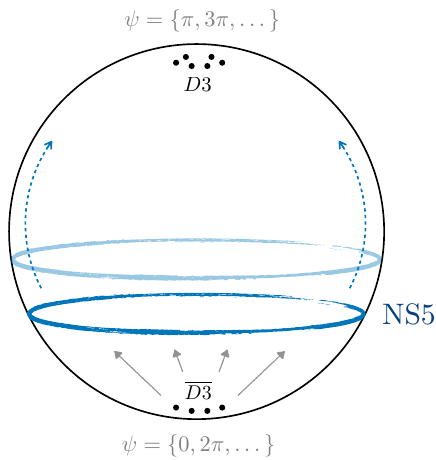
Figure 1 . A schematic illustration of the brane-(cid:13)ux annihilation process. A number p of anti-D3- branes, localised at the south pole, polarise into an NS5-brane wrapping a contractible cycle along the S 3 . The axionic (cid:12)eld describes the position of the NS5-brane, with a periodicity of 2 (cid:25) . The south pole is at = 0 ; 2 (cid:25); : : : , while the north pole is at = f g when all the anti-brane charge is neutralised by the (cid:13)uxes at the north pole, where the NS5 can be described in terms of M p (cid:0)